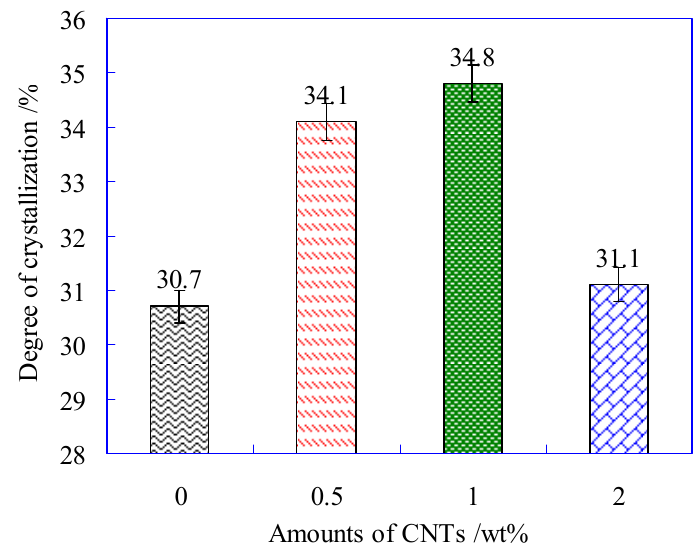
Figure 4. Degree of crystallization of PLA fiber with different contents of CNTs.